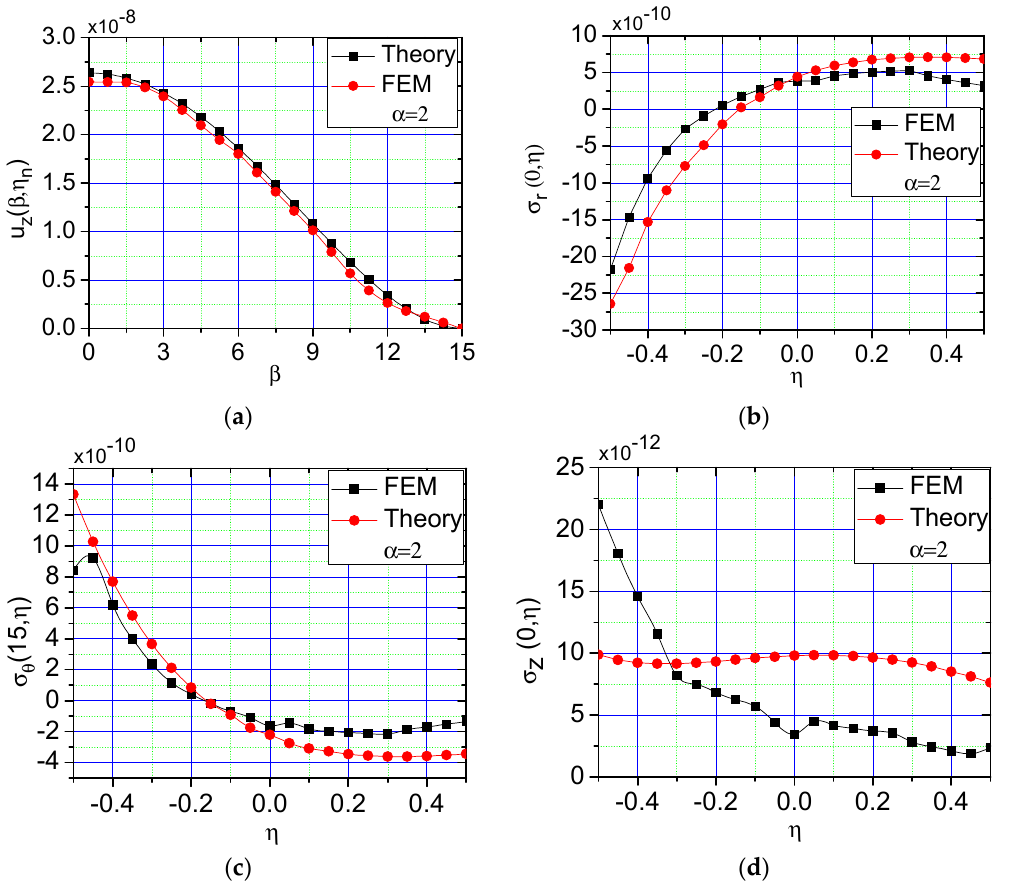
Figure 3. Comparisons between theoretical solutions and numerical results: ( a ) deflection at the neutral layer, ( b ) radial stress at plate center, ( c ) circumferential stress at plate’s edge, and ( d ) z -direction stress at plate center.